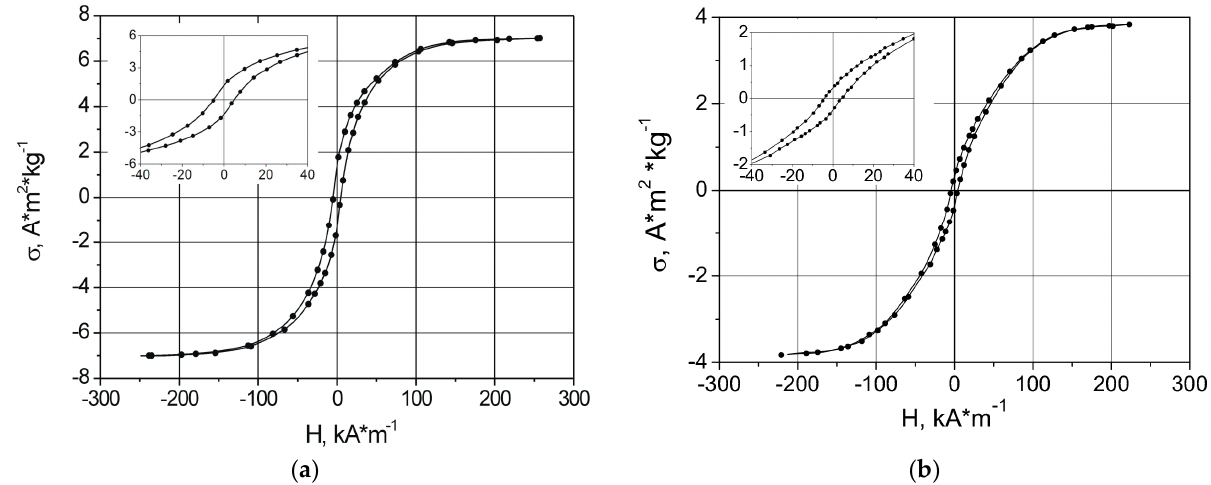
Figure 3. σ -H loops for Ni/C composites ACB-Ni ( a ) and ACC-Ni ( b ). The region of the low magnetic field is shown in the inset.